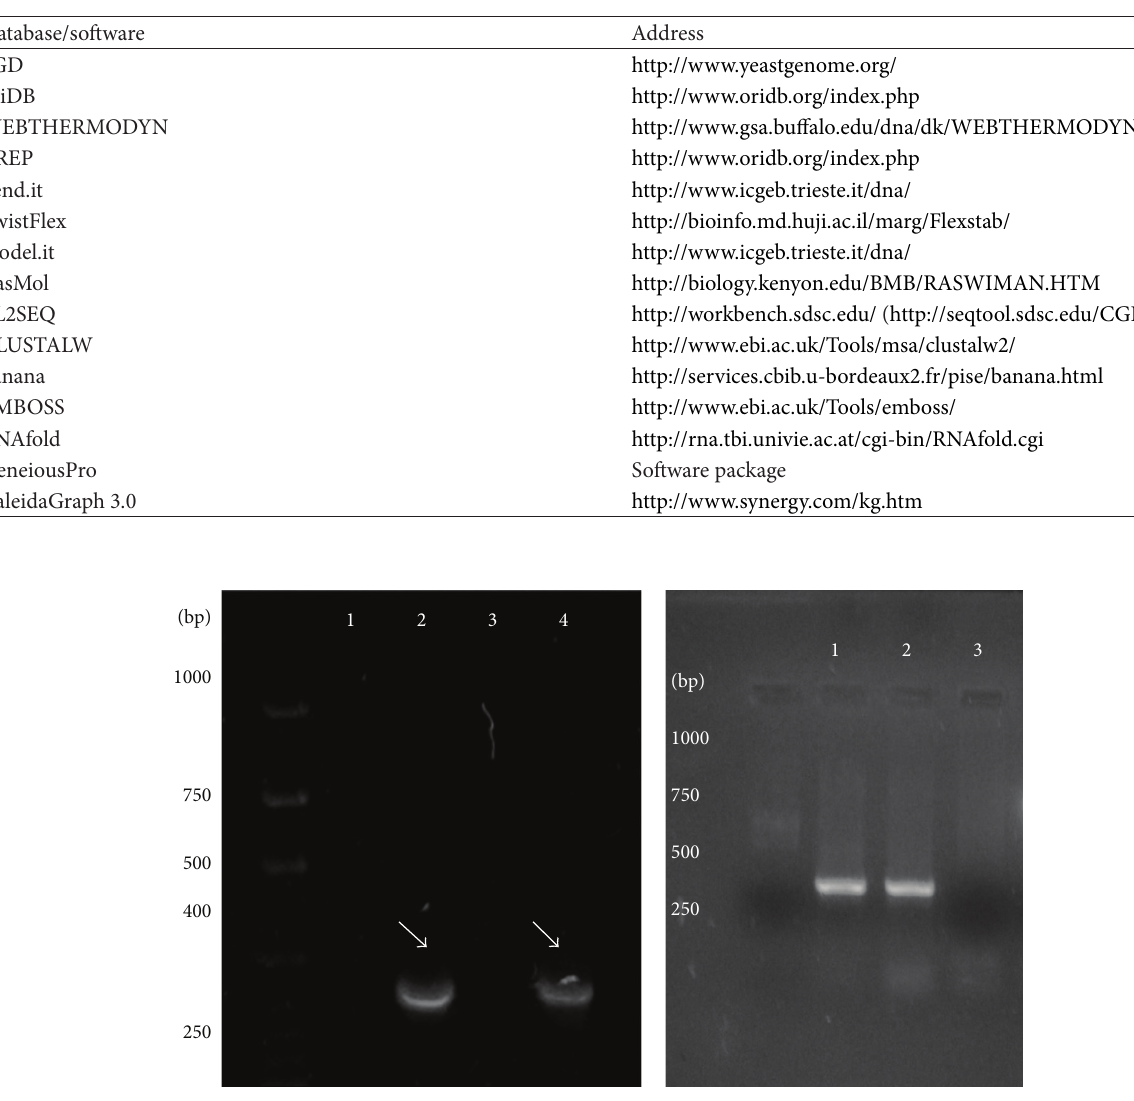
Table 5: Software/online tools used in the present study.